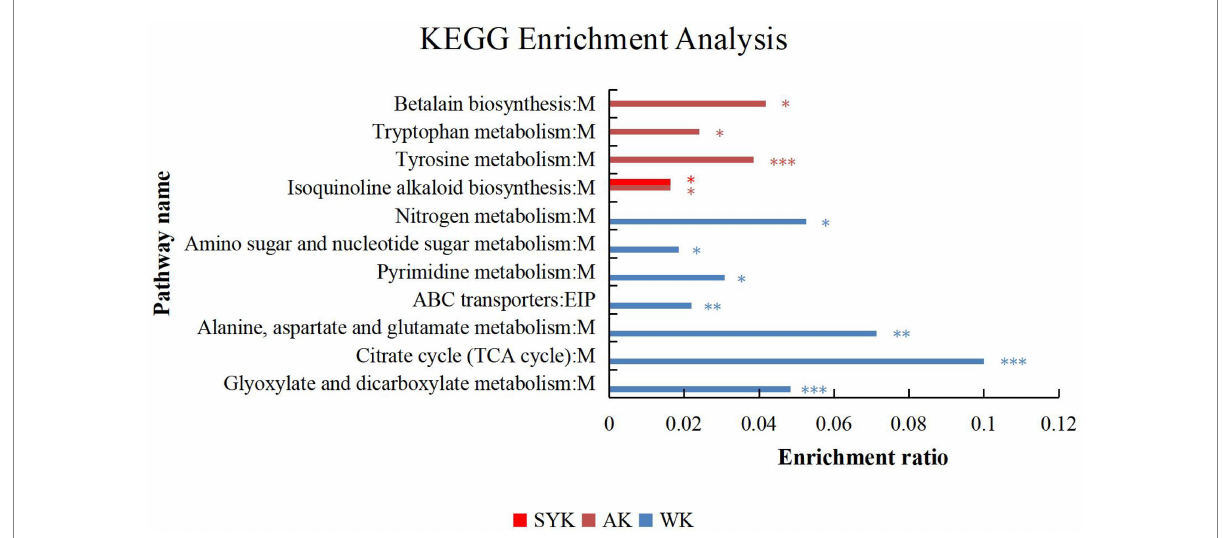
FIGURE 6 KEGG pathway enrichment analysis of the main differential metabolites of ryegrass silage from three different regions in positive and negative ion modes (WK, Ordos; AK, Hohhot; SYK, Ulanqab). M, and EIP are the class names of metabolic pathways in KEGG annotation. M, metabolism; EIP, environmental information processing. Value of p -uncorrected <0.05 and column chart showing value of p values for the top 20 pathways; * p < 0.05; ** p < 0.01, *** p <